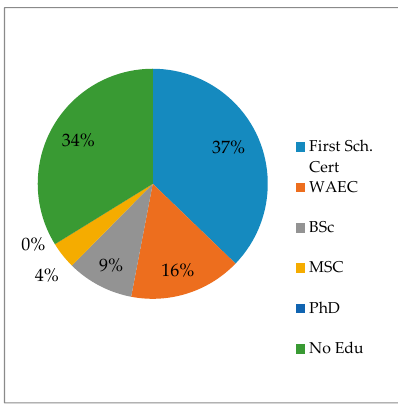
Figure 2. Educational background status of respondents from the five states of South eastern, Nigeria.